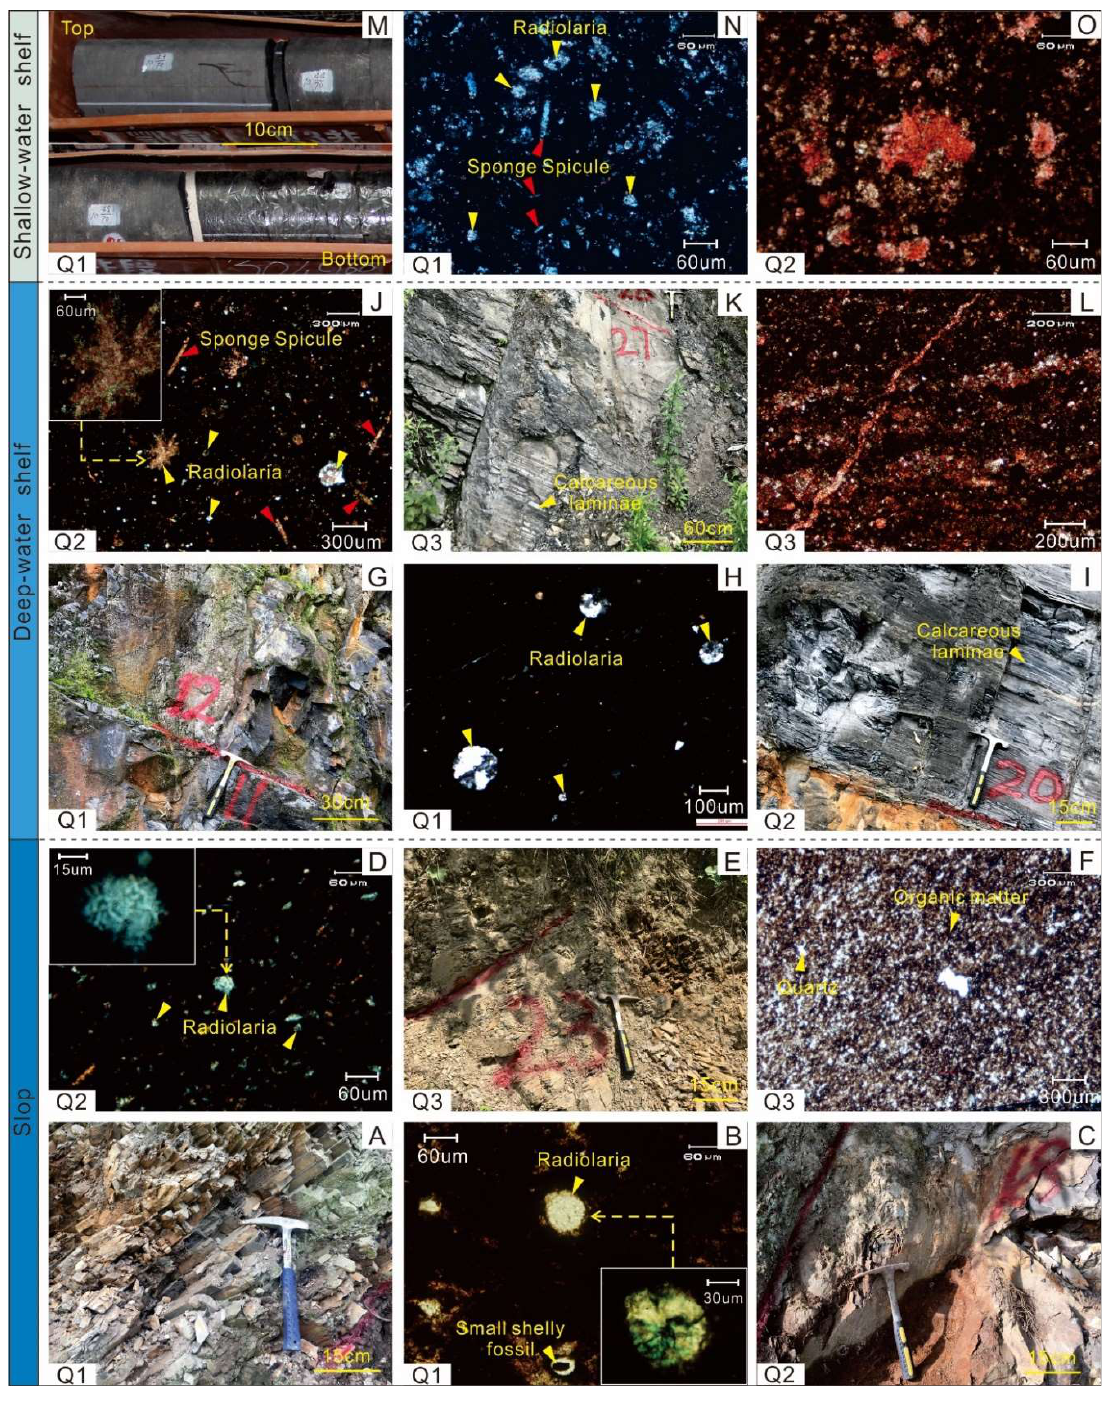
Figure 3. Sedimentological and mineralogical-petrological characteristics of the Qiongzhusi For- mation in the western Middle Yangtze Block along the slope → deep-water shelf → shallow-water shelf continuum. Slope ( A – F ): (A) gray-black siliceous shale in bed 3 of the Qiong 1 Member (Q1) in Duodingguan; ( B ) siliceous shale rich in siliceous radiolarians and small shell fossils (with a shell wall composed of a single siliceous layer) collected from the bottom of bed 3 of Q1 in Duodingguan and observed under plane polarized light, with a magnified image of radiolarians under cross-polarized light in the lower right inset; ( C ) gray-black siliceous shale from bed 18 of the Qiong 2 Member (Q2) in Duodingguan; ( D ) siliceous shale rich in siliceous radiolarians and siliceous bioclasts collected from Q2 in Duodingguan and observed under cross-polarized light; ( E ) gray silty shale with a bamboo